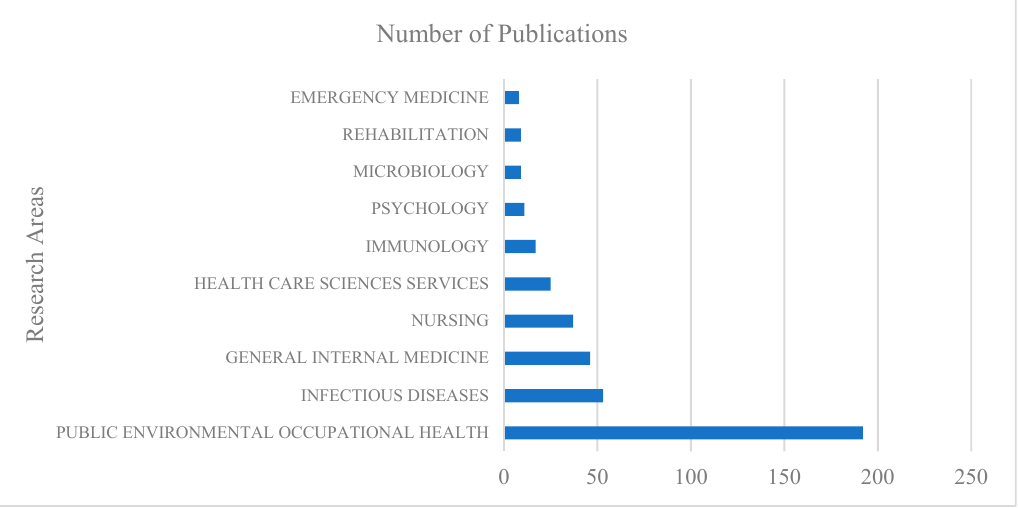
Figure 2. Research area distribution of HCWs + OH in WOSCC.